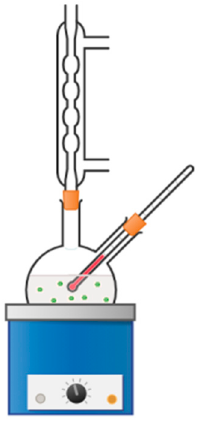
Figure 7. Scheme of the apparatus used for carrying out the reaction of styrene oxidation. The molar ratio of reagents was: C 2 H 3 N:H 2 O 2 :C 8 H 8 = 1:1:1. After reaching 60 °C, 10 mg of the catalyst was added. Reaction was then carried out for 2 h. After that time, samples for gas chromatography were probed.